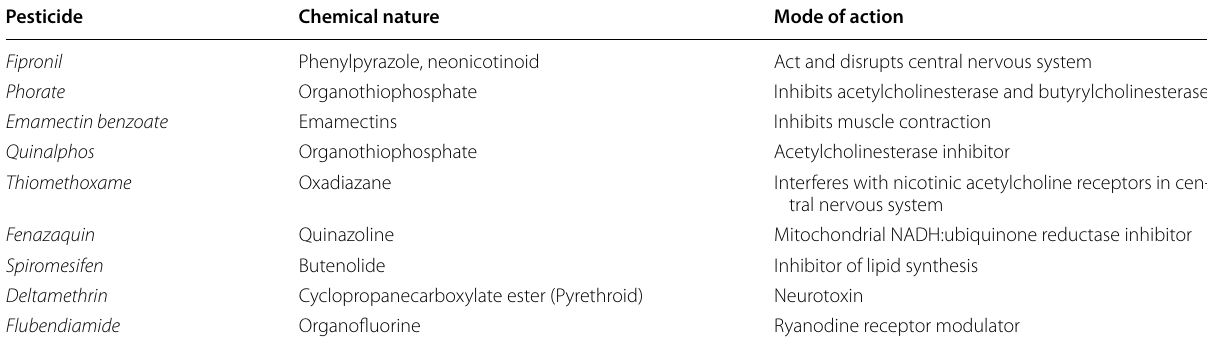
Table 3 Chemical nature and mode of action of the pesticides experimented